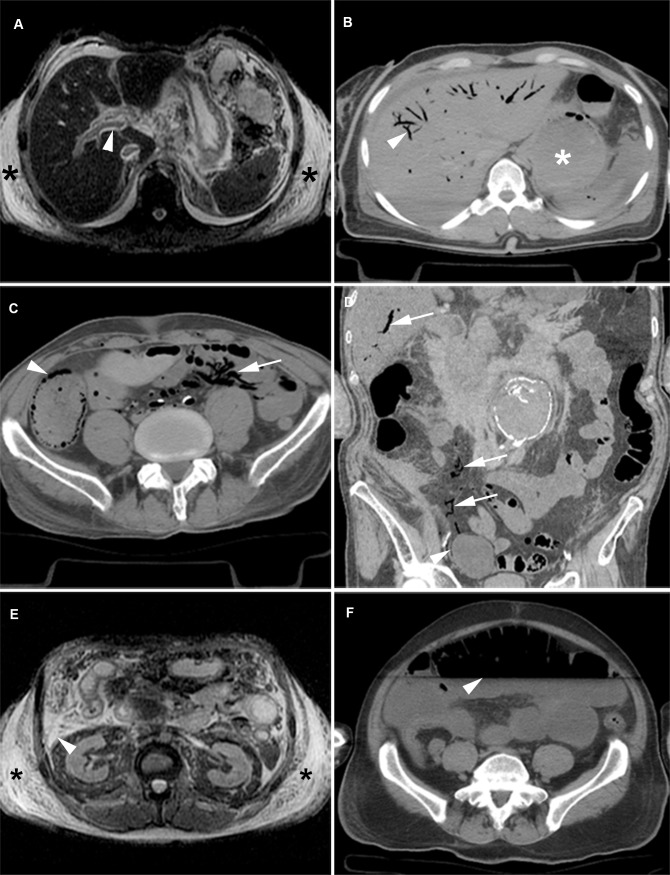
Postmortem imaging features of the abdomen.(A) T2w PMMR: Periportal edema (arrowhead) and subcutaneous edema (asterisks). (B) PMCT: Putrefactive gas in the liver vessels (arrowhead) and distended stomach (asterisk). (C/ D) PMCT: Gas in the intestinal wall (arrowhead) and air in the mesenteric and portal veins (arrows). (E) T2w PMMR: Subcutaneous edema (asterisks) and fluid in the abdomen (arrowhead). (F) PMCT: Distended intestines with a sharp fluid-air level (arrowhead).